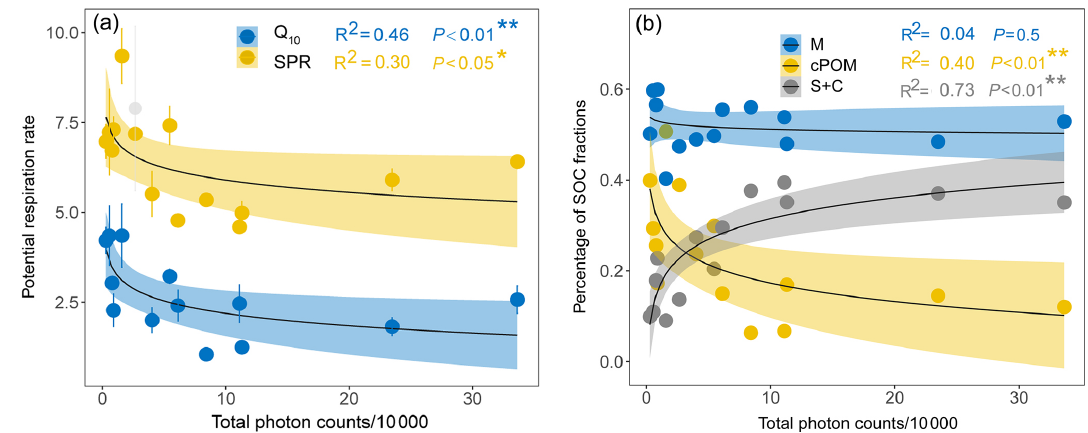
Figure 5. Relation between relative terrace soil burial age (total photon counts) and (a) SPR rates and SOC temperature sensitivity to decomposition ( Q 10 ), and (b) contribution of SOC fraction to total SOC. Error bars denote 1 standard deviation of SPR measurements ( N = 3). Formula: y = log (x) . cPOM = coarse particulate SOC; M = microaggregate-associated SOC; S + C = silt- and clay-associated SOC. Data points are from all terrace profiles. ∗ = P < 0.05; ∗∗ P < 0.01.